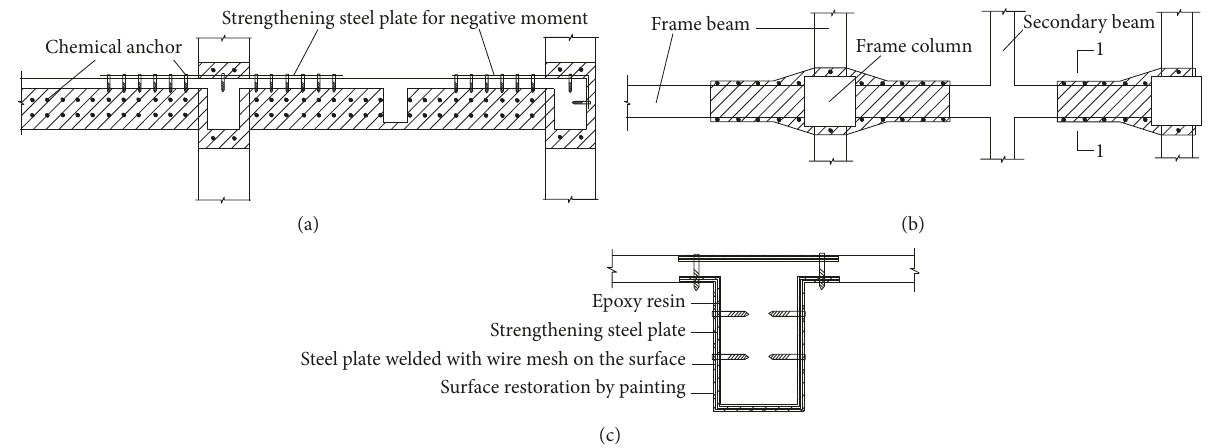
Figure 4: Schematic diagram of the strengthening constructional method: (a) reinforcement elevation; (b) reinforcement plane; (c) reinforcement profile (1-1